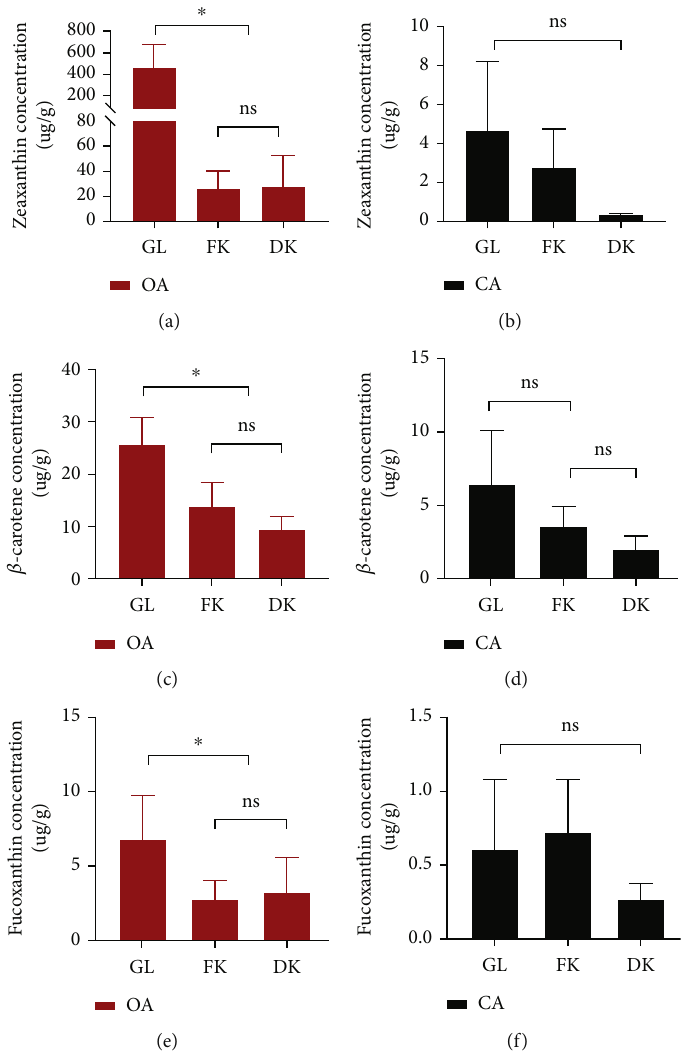
Figure 2: Quantities of three carotenoids in H. gigantea muscles with di ff erent colors under various diets after 12